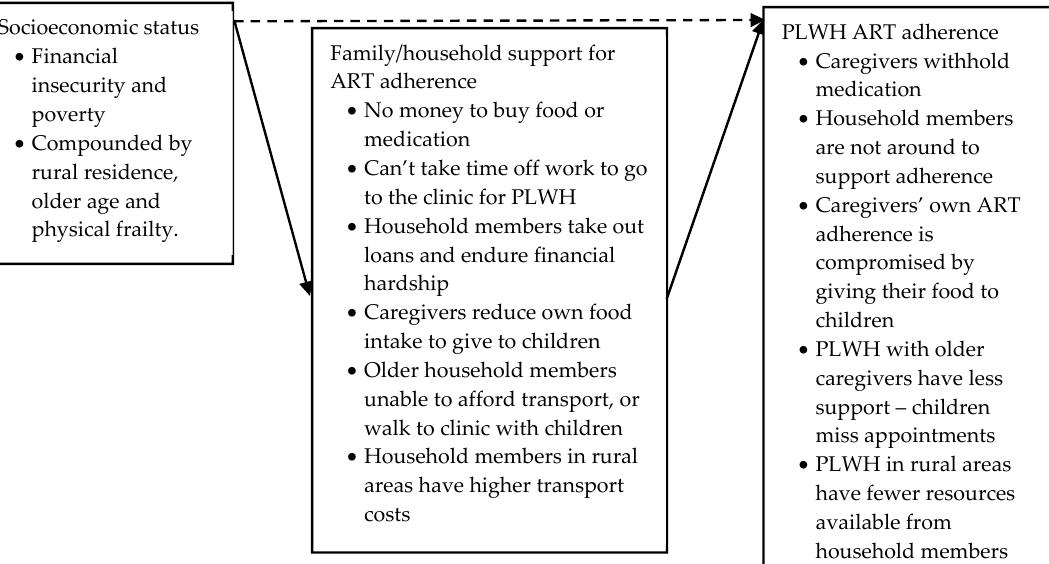
Figure 7. Studies either measured the direct impact of socioeconomic status on ART adherence or examined how socioeconomic status impacts ART adherence via household